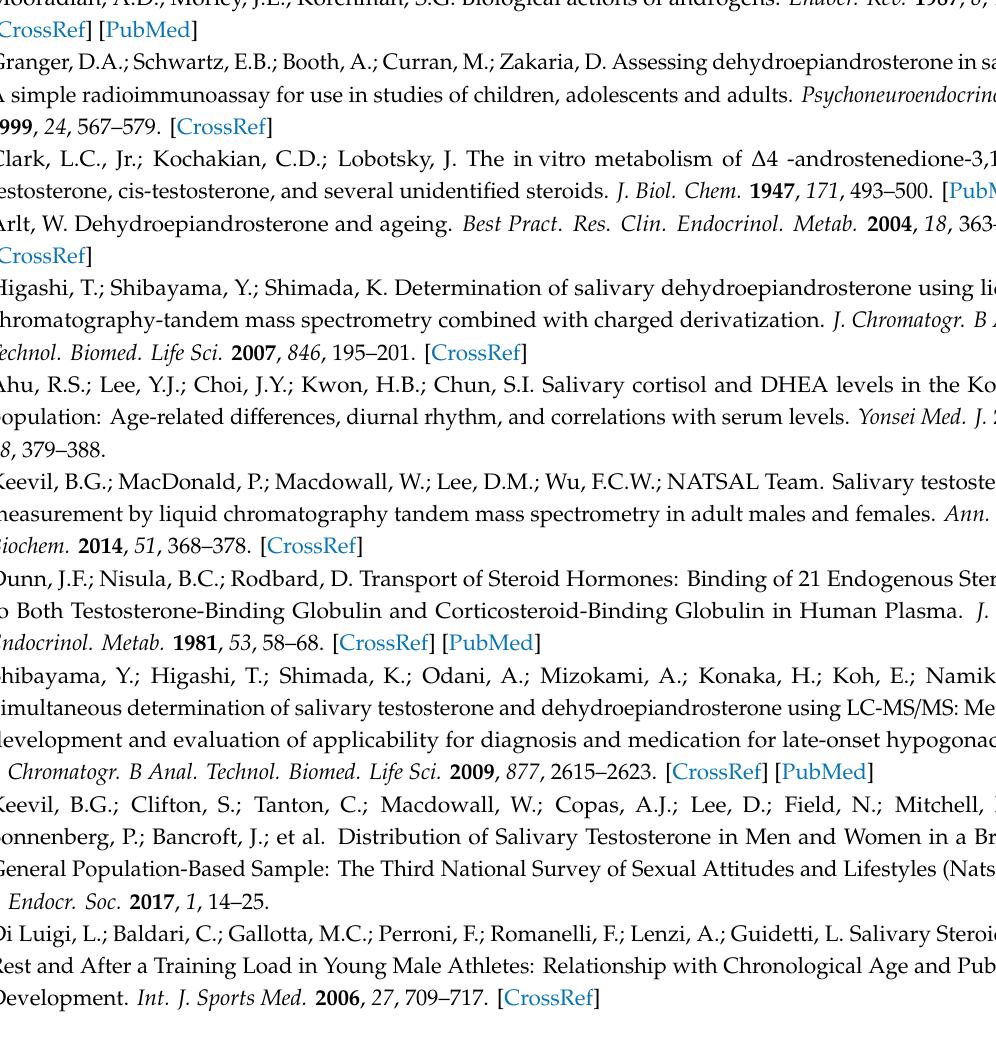
Figure S1: Structures of derivatization 2-Hydrazino-1-methylpyridine derivative (HMP) with testosterone, dehydroepiandrosterone and epitestosterone; Figure S2: Optimization of reaction conditions in derivatization steroids with HMP; Figure S3: Solid phase extraction cartridge selection.; Figure S4: Matrix E ff ect; Figure S5: Linearity and calibration of standards spiked into saliva; Figure S6: Correlation between the concentrations of Sal-DHEA and Sal-T ( n = 20) were (A) pre-training and (B)